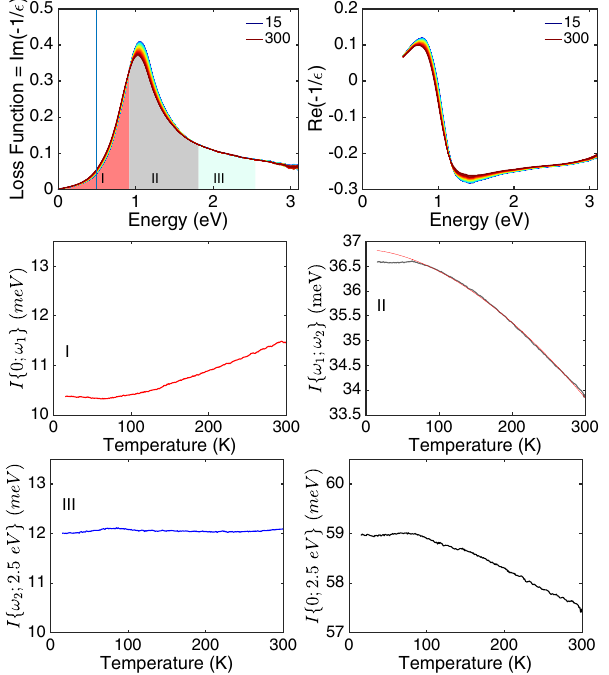
FIG. 15. Sample Bi2212-58-OD. Caption details as in Fig. 8. The value of the fitted exponent α is loss-function integrals as a function of temperature in different frequency domains. In the top panels of Figs. 8 – 15 are displayed: imaginary (left panel) and real (right panel) parts of − ϵ ð ω Þ − 1 for selected temperatures. The curves in the interval on the left of the vertical blue line are Drude-Lorentz oscillator fits to the experimental com- plex loss function in the range 0.6 – 3.1 eV. The second and third rows from left to right are as follows: Integral of the loss function of the red, gray, blue, and total areas as a function of temperature. The right middle panel shows power-law temperature dependence B þ AT α , fitted to the data in the normal state.